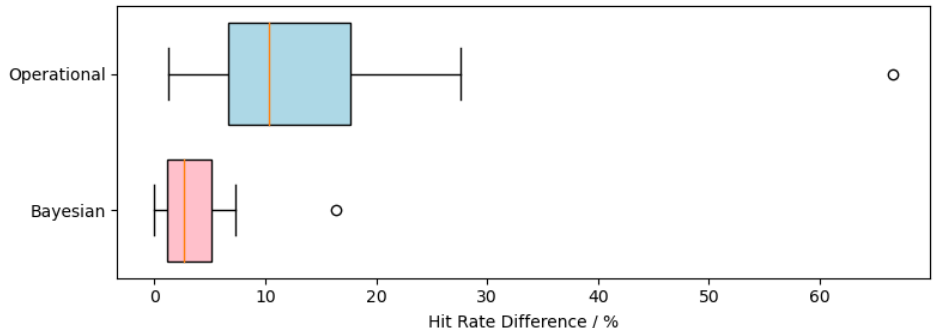
Figure 4. Box and whisker plot comparing the hit rate percentage difference between sensor pairs (ATSR2 vs. AATSR, AATSR vs. MODIS and MODIS vs. SLSTR) for all locations in Table 7 for the Bayesian cloud mask ( bottom ) and the various operational cloud masks ( top ). The red line shows the median difference and the edges of the boxes represent the 25th and 75th percentiles.